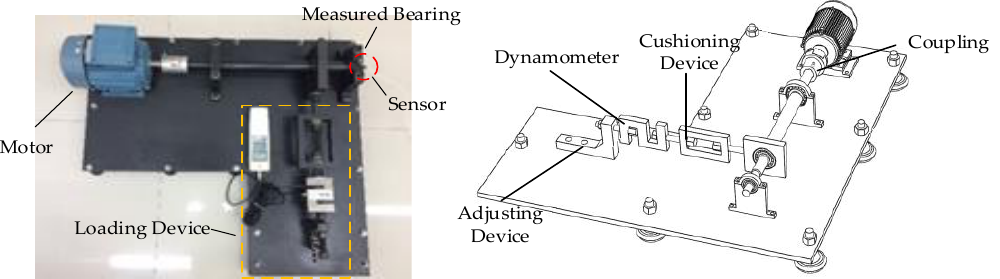
Figure 4. Test rig for bearing signals.